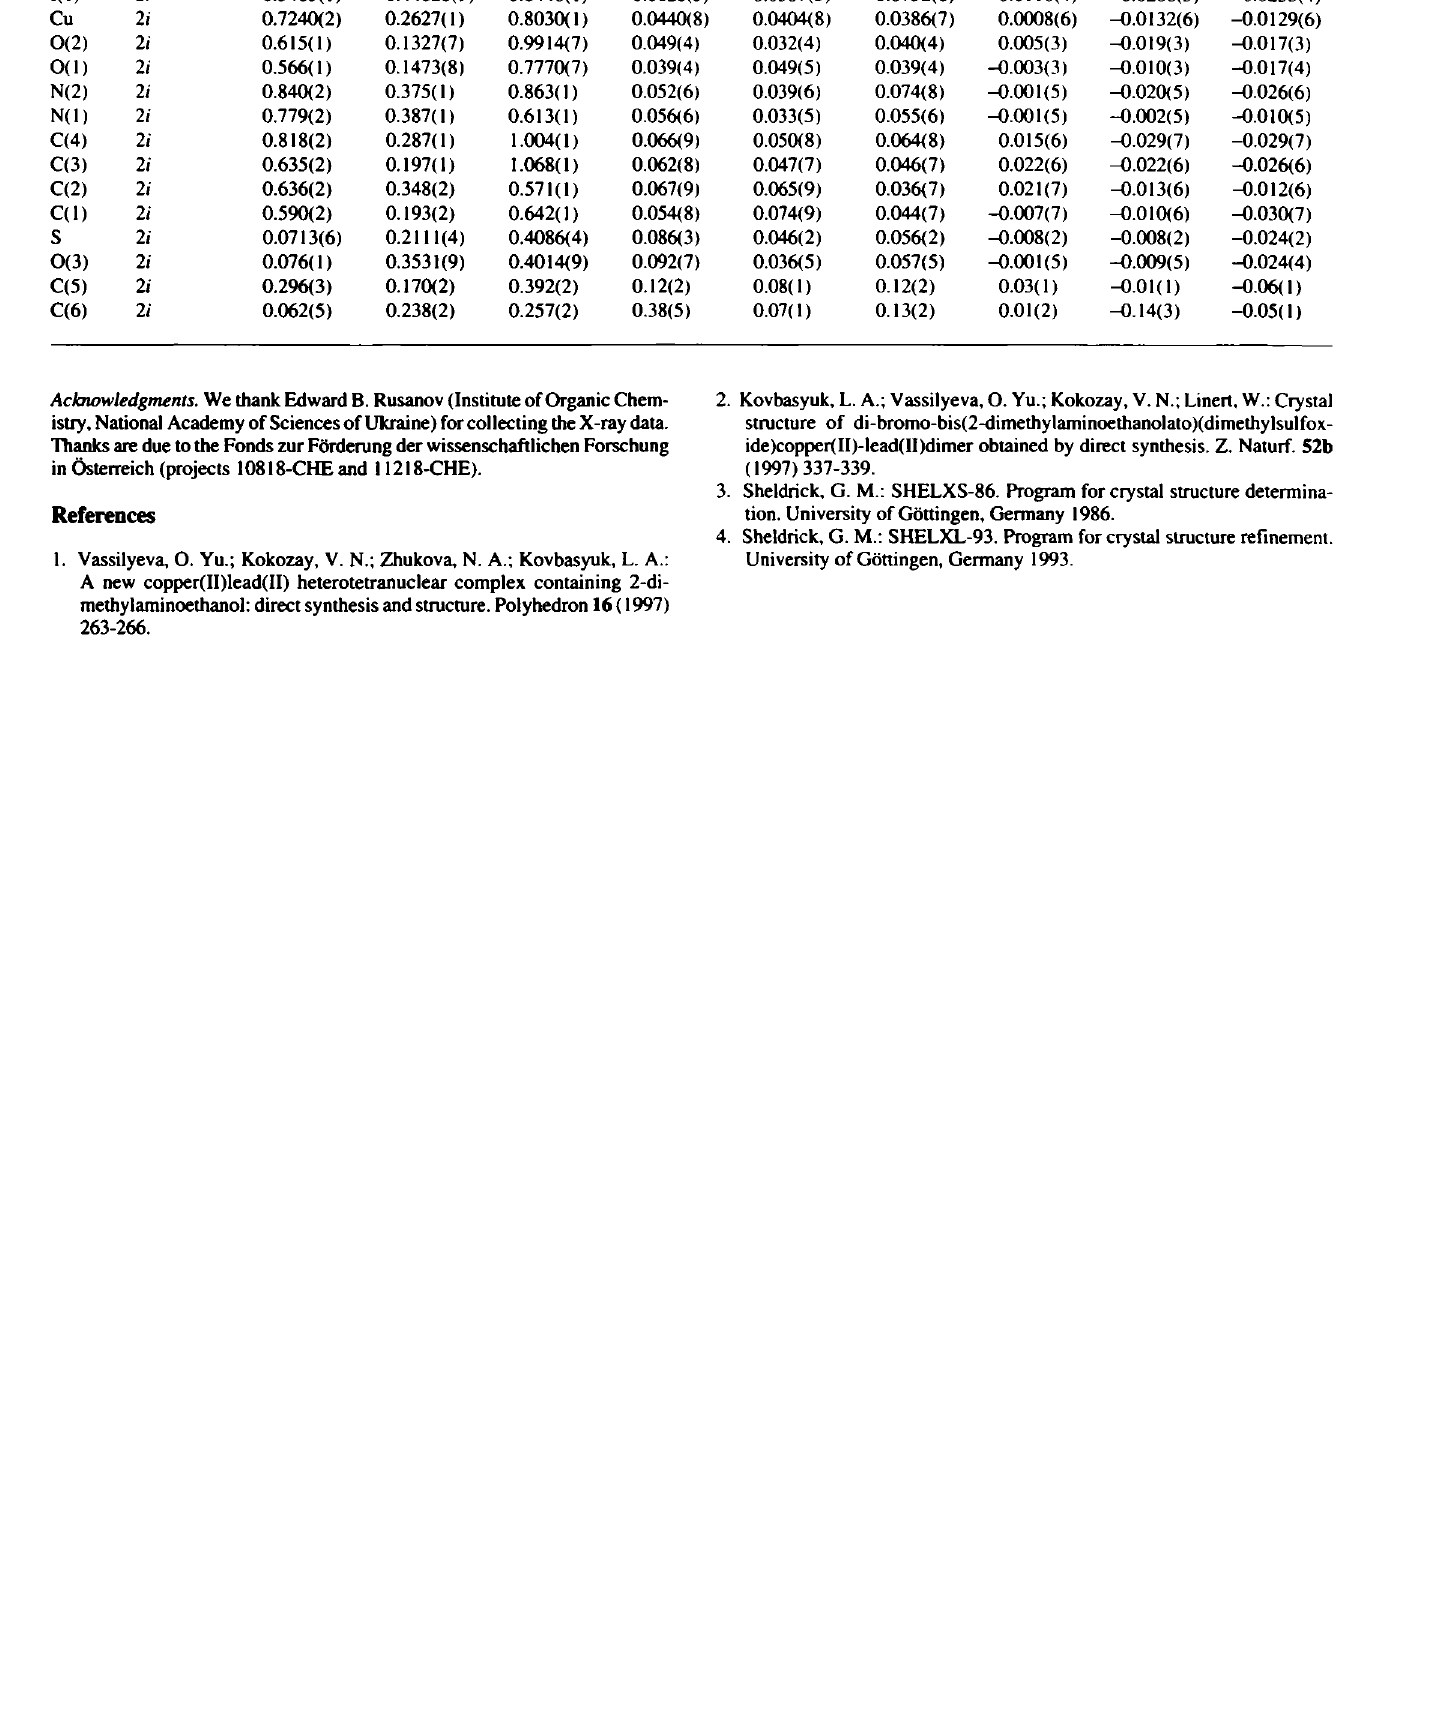
Table 3. Final atomic coordinates and displacement parameters (in